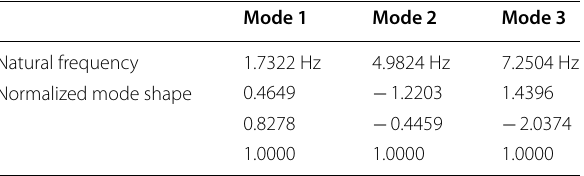
Table 3 Modal parameters by spectral analysis.